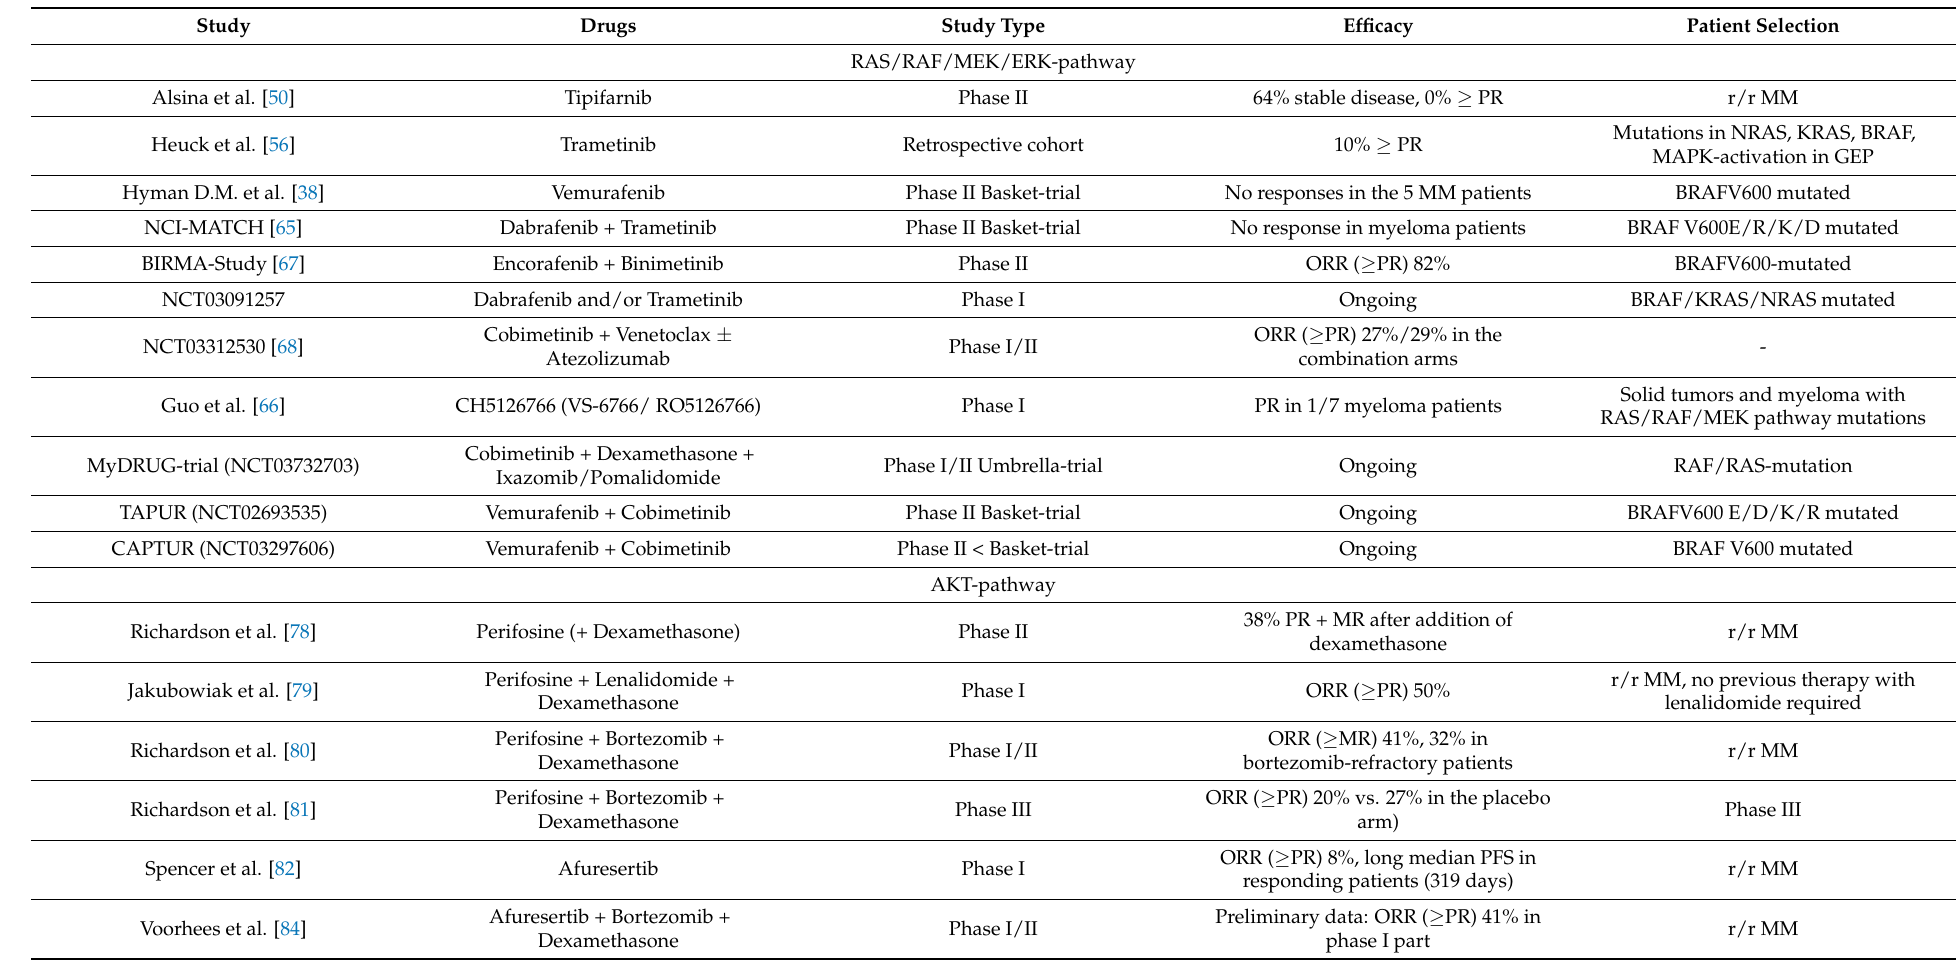
Table 1. Overview on pathway directed therapies in multiple